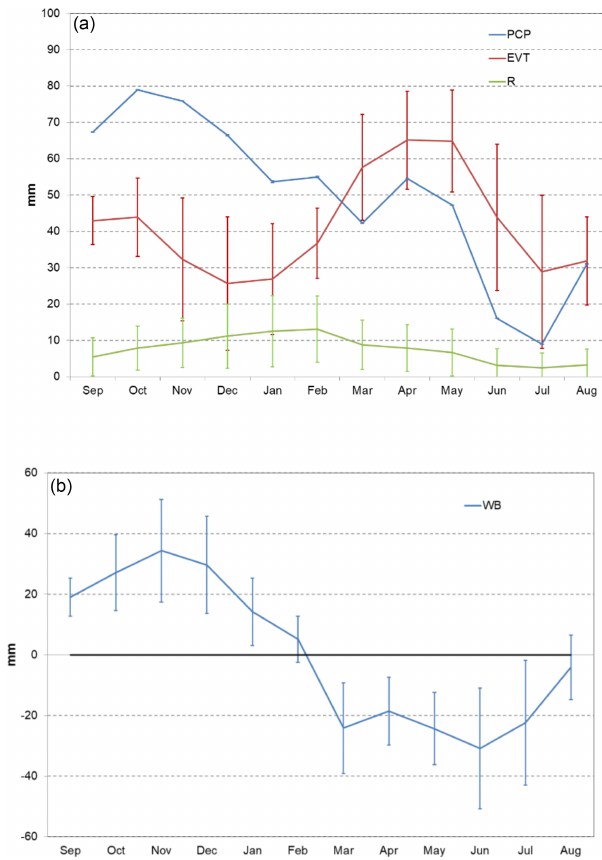
Figure 7. (a) Components of the climatic water balance (1981– 2010) at the grid point nearest to the Mallorca airport, deduced using data from the European Earth2Observe project. Vertical bars represent standard deviation among the eight models. (b) Water bal- ance at the same grid point (see text for